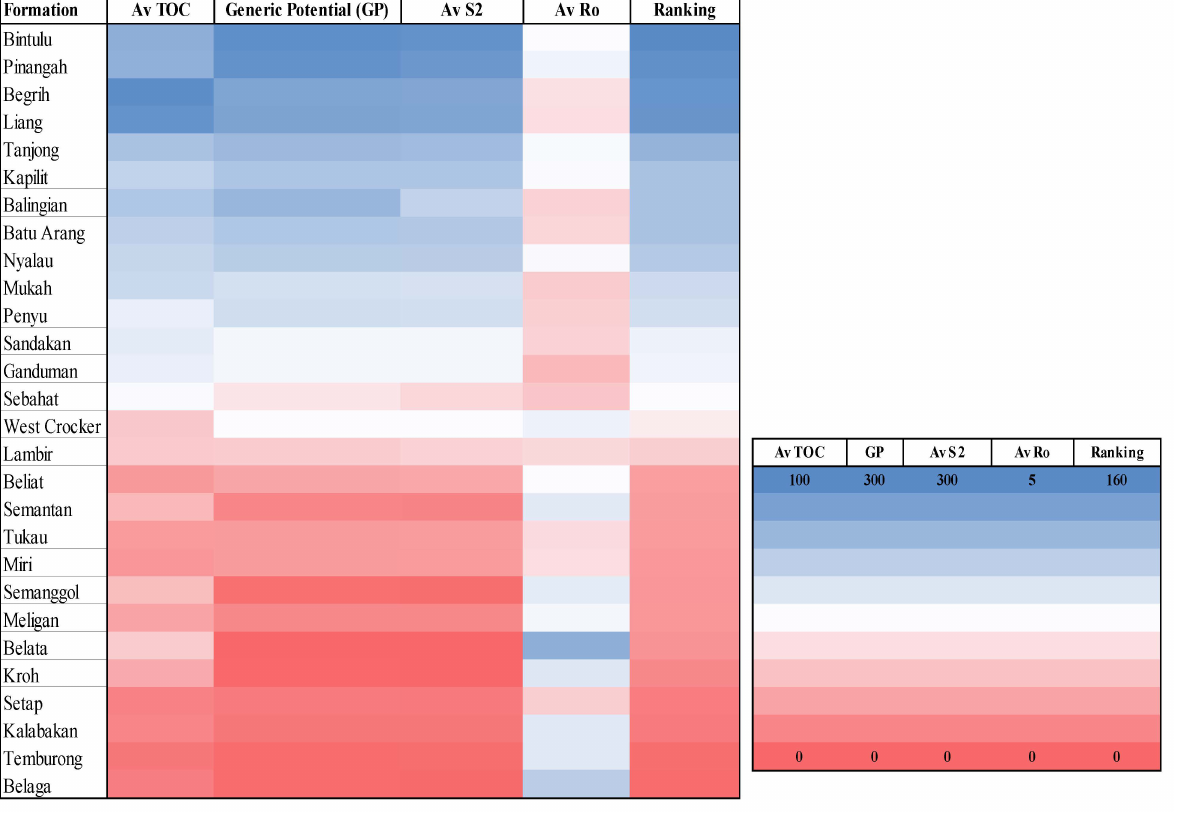
Figure 18. Heat map showing the ranking of hydrocarbon generation potential of formations in